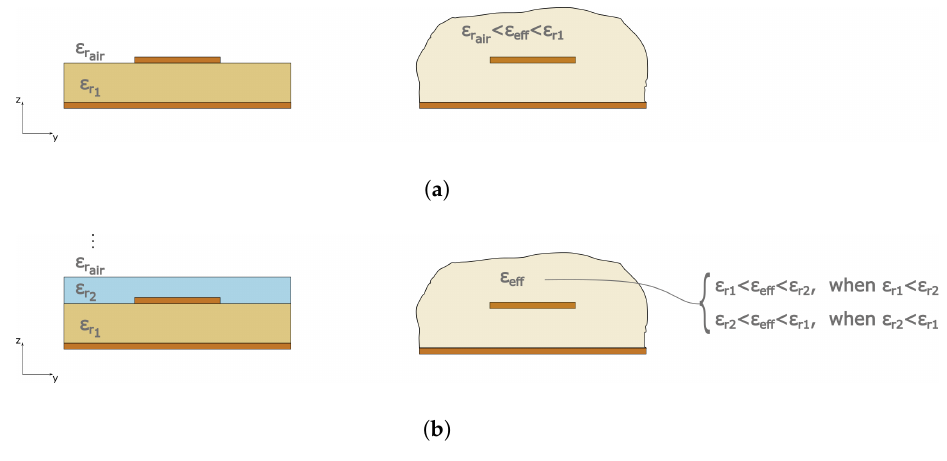
Figure 2. Schematic vision of the effective permittivity concept in the case of ( a ) the classical microstrip transmission line and ( b ) microstrip transmission line embedded in a multi-layer